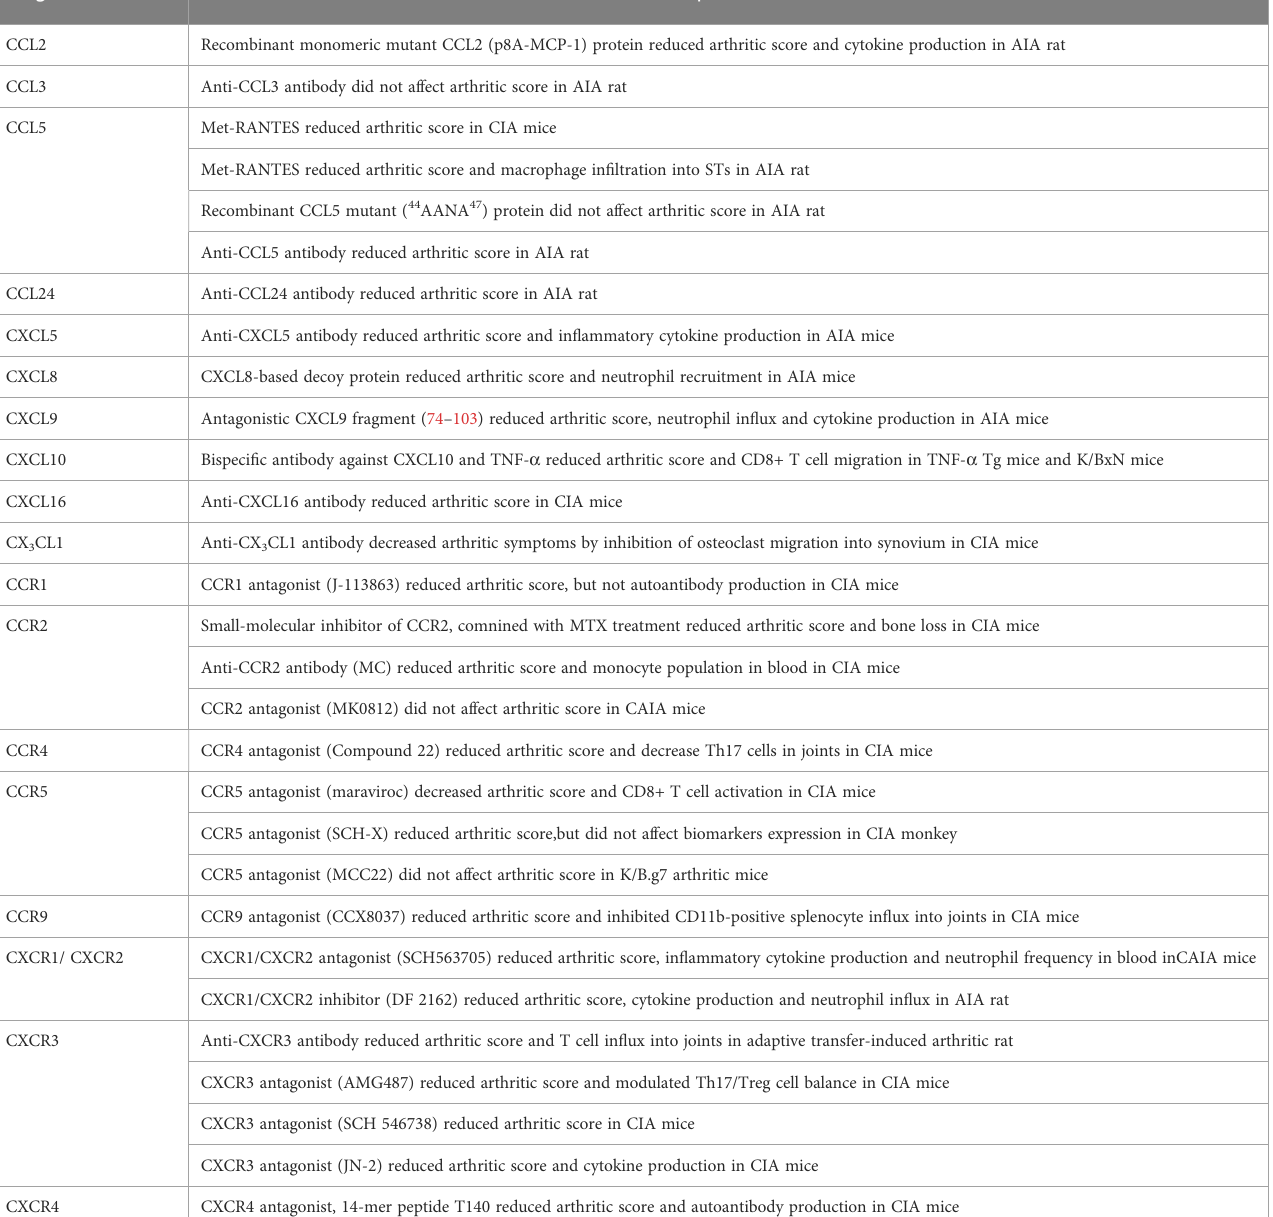
TABLE 5 The therapeutic effect of chemokine-targeted agents in RA